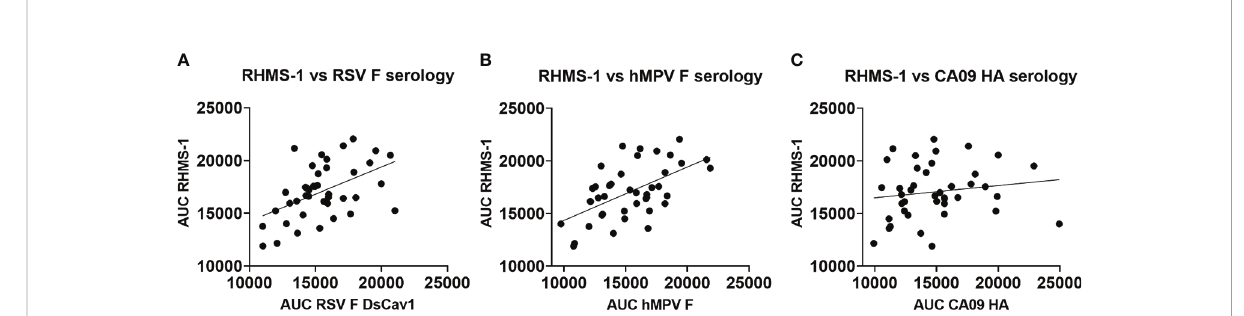
FIGURE 4 Serology of human plasma against F proteins. Area under the curve analysis of plasma IgG binding to RHMS-1 vs. RSV A2 F DsCav1 (A) , RHMS-1 vs. trypsinized hMPV B2 F monomer (B) , and RHMS-1 vs. in fl uenza HA (A/California/07/2009). Each dot represents one subject, and the lines indicate the linear regression fi t of the data sets (R 2 = 0.174, p=0.0067 for (A) ; R 2 = 0.324, p=0.0001 for (B) ; R 2 = 0.023, p=0.347 for (C) ]. Figures and data analysis was generated by GraphPad